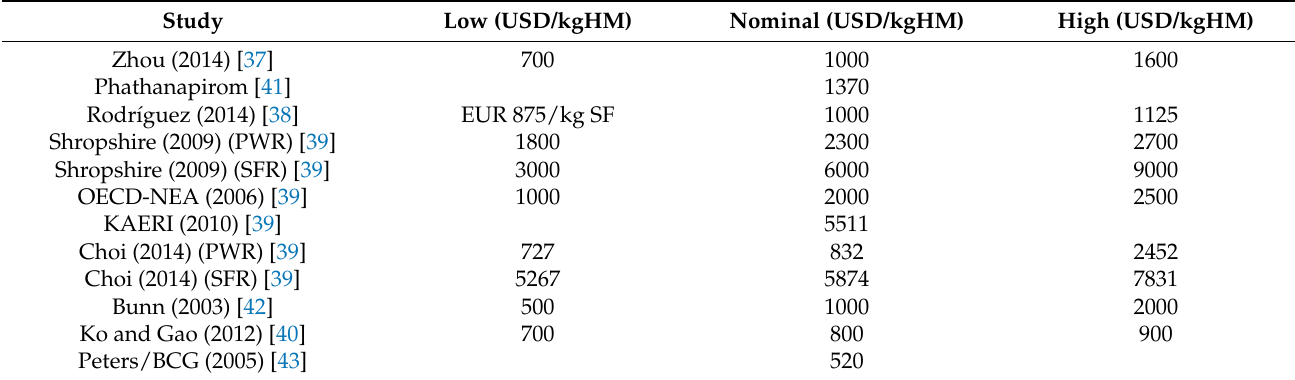
Table 2. Reprocessing costs used in economic studies of fuel cycle